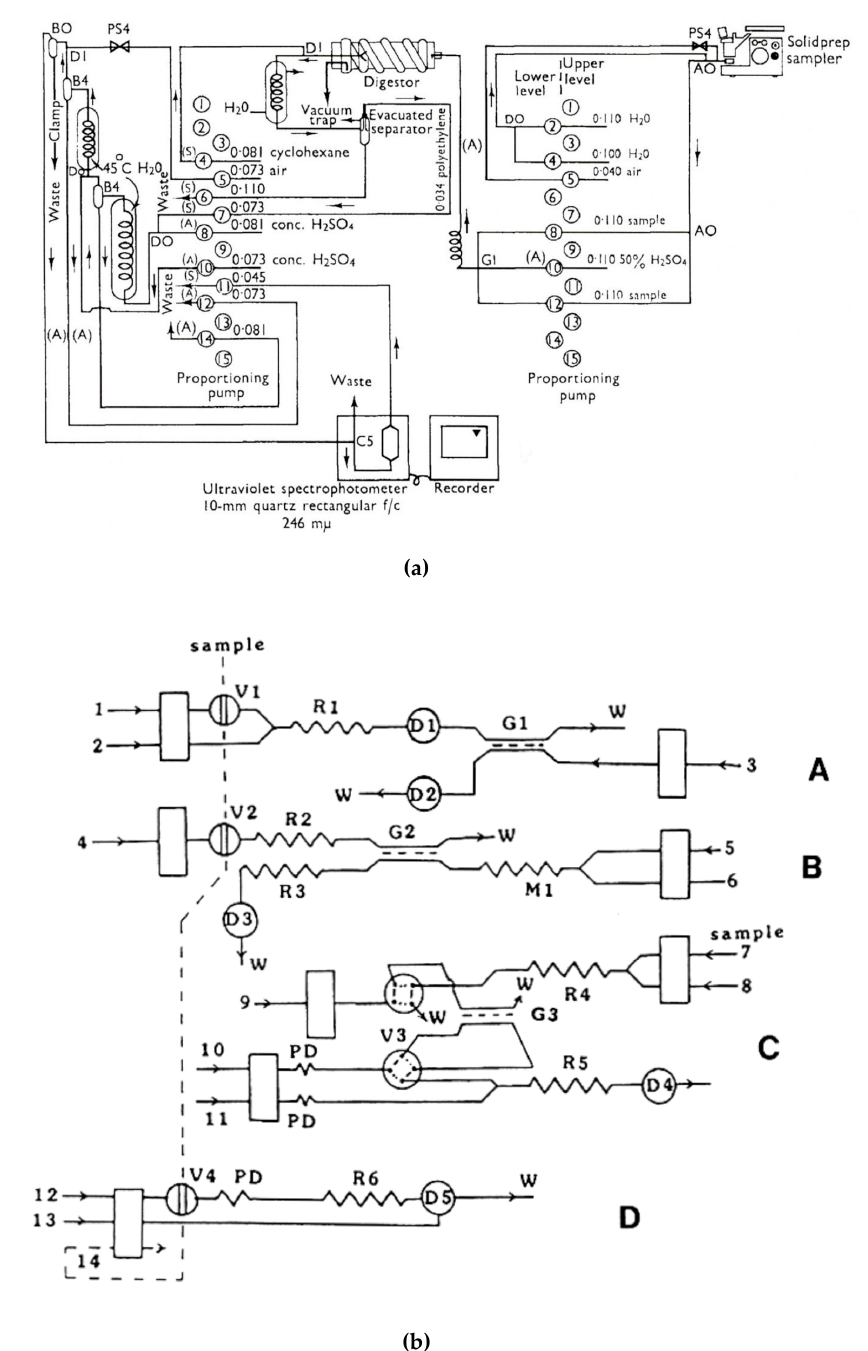
Figure 1. Schematic diagrams of multistep flow analytical systems: ( a ) air-segmented continu- ous-flow system for the determination of biphenyl pesticide in citrus fruit rind involving in-line distillation and ultraviolet (UV) detection [113]; ( b ) flow-injection system for simultaneous photometric determination of sulfide, polysulfide, sulfite, thiosulfate, and sulfate [114]. A—manifold for determination of sulfide and polysulfide; B—manifold for determination of sulfite; C—manifold for determination of thiosulfate; D—manifold for determination of